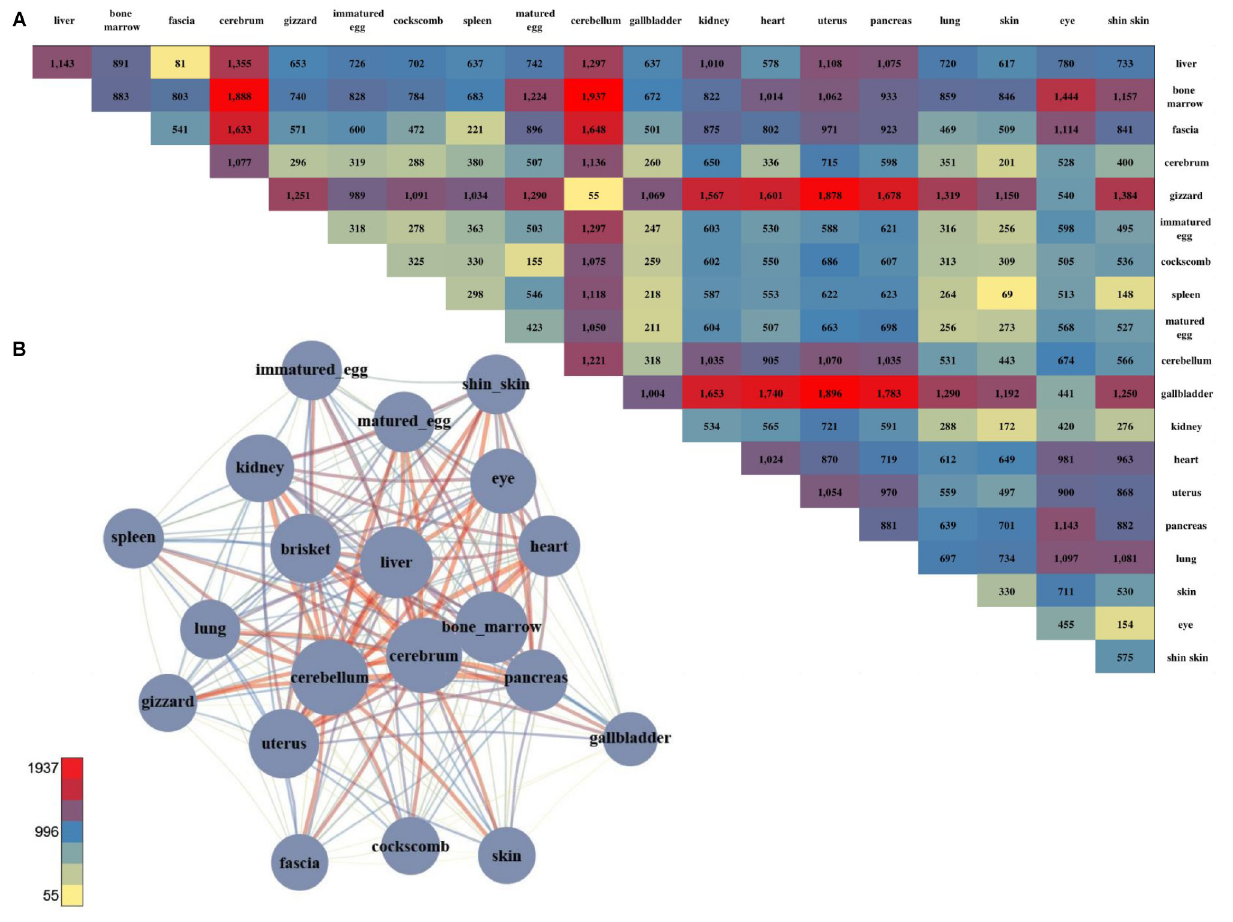
FIGURE 2 | The number of DEGs and the pair-wise comparison of the 20 tissues. (A) The number of DEGs that were compared with each other among the 20 tissues. (B) Network created using the DEGs. The total number of DEGs in a given condition is represented by a node, and the number of DEGs in the condition is indicated by an